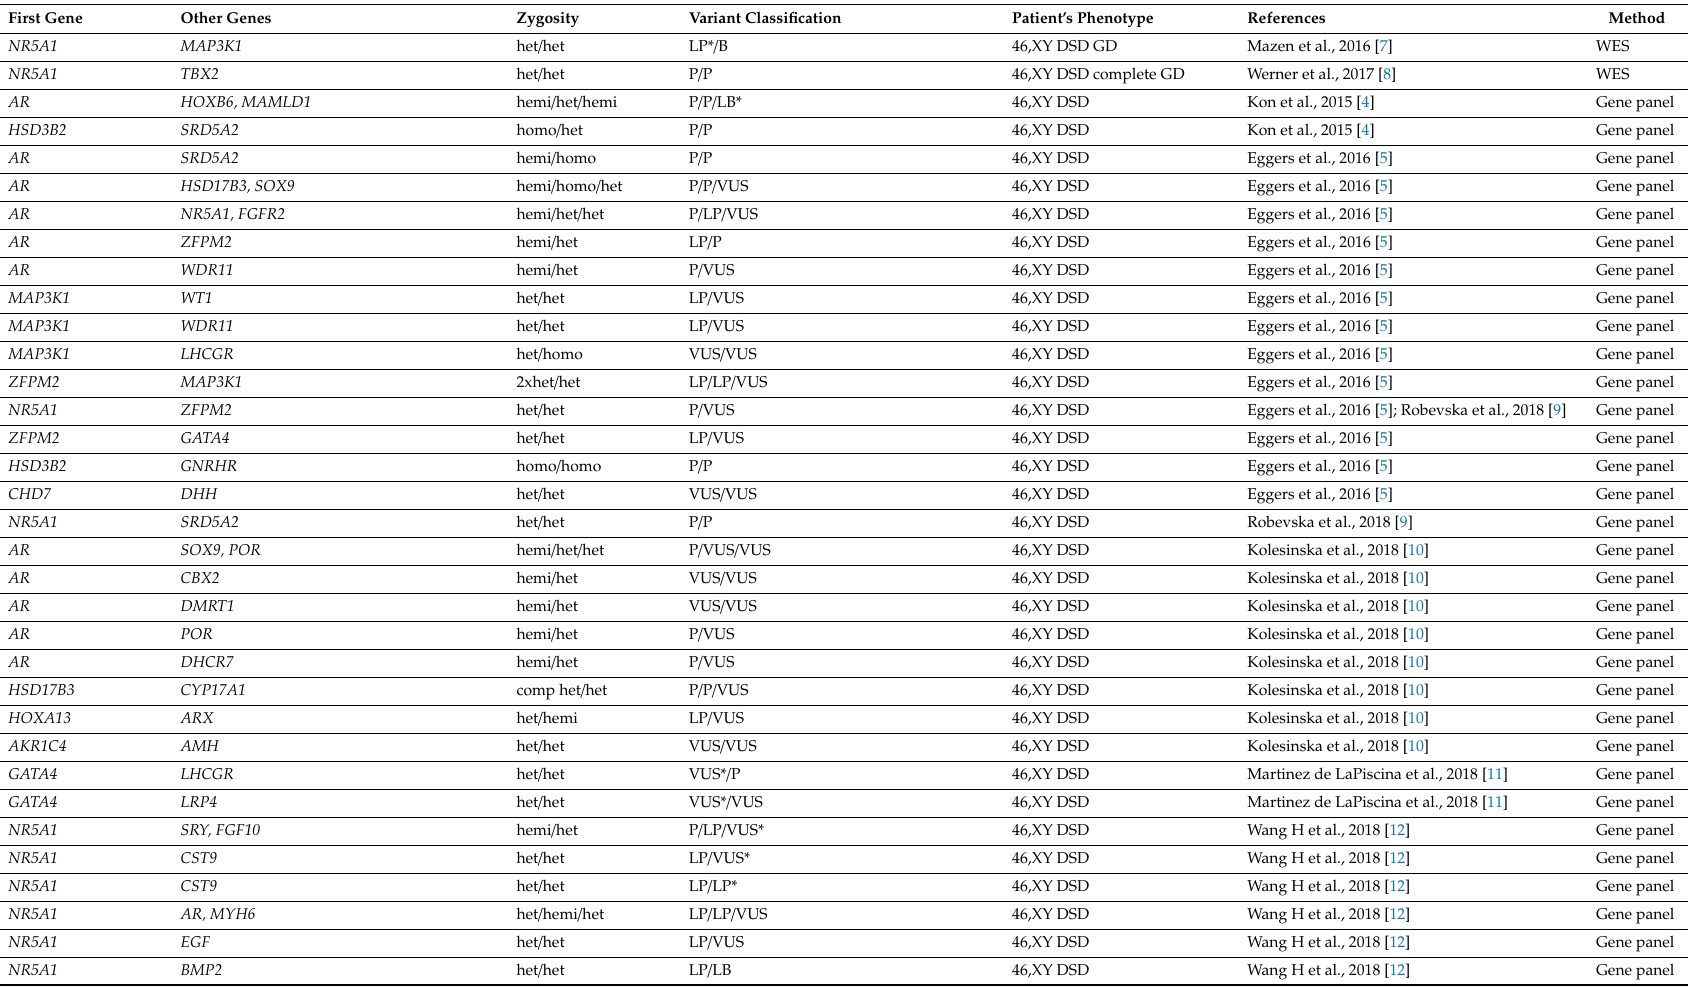
Table 1. Oligogenic disorders / di ff erences of sex development (DSDs) described by high throughput sequencing (HTS)